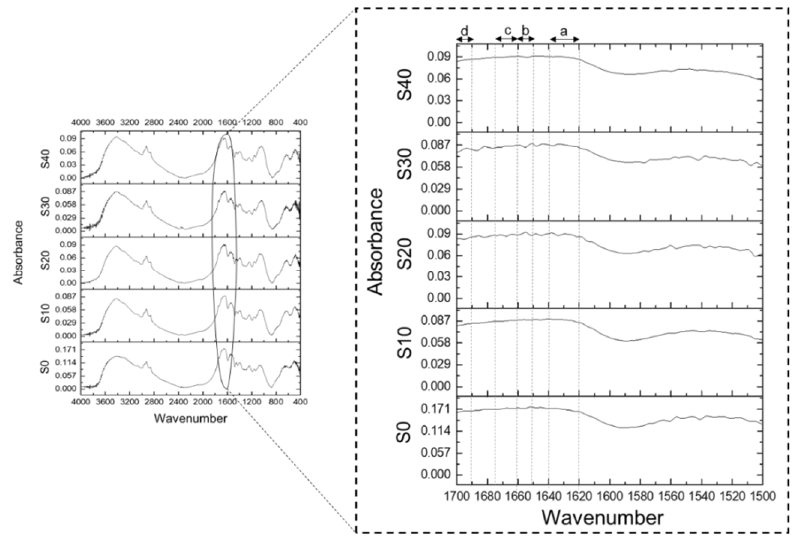
Figure 5. (a) FTIR spectra of MY–PPI blends LMMA in amide II and amide I regions. β -sheets, (b) α -helix, (c) β -turn and loops, and (d) antiparallel β -sheets.